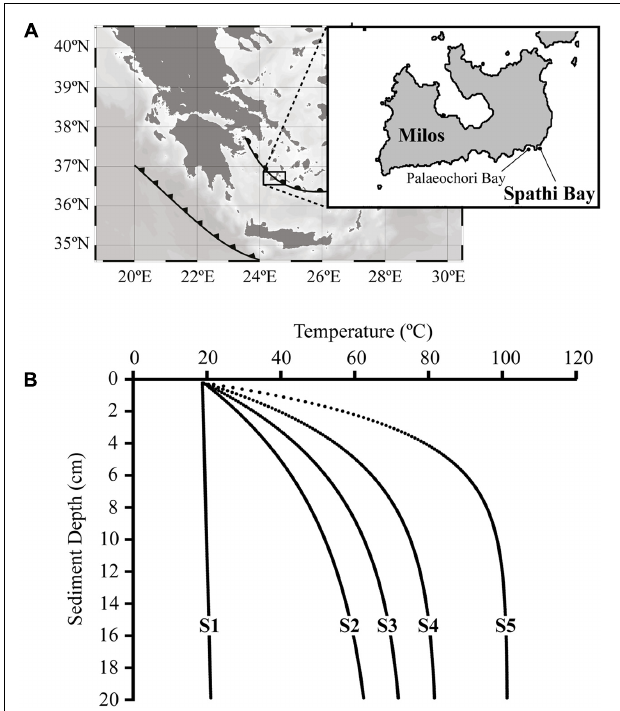
FIGURE 1 | The thermal gradient studied in sediments of Spathi Bay, Milos Island, Greece. (A) As part of the Hellenic back-arc and fault (semi-circles and triangles, respectively), Milos Island is one of the largest hydrothermal systems of the Mediterranean Sea [modified after Giovannelli et al. (2013)]. The study site Spathi Bay is located 500 m away from Palaeochori Bay, where most geochemical and microbiological investigations from Milos Island have been performed (see Main Text). (B) Modeled temperature profiles in sediments of Spathi Bay calculated for every 100 µ m from surface until 20 cm of sediment depth (see Materials and Methods section). Prior to sampling, stations S1 to S5 were selected based on temperatures recorded in situ at 5 cm sediment depth. Station S1 represents the reference sediments with temperatures below 20 ◦ C, while hydrothermally influenced stations S2 to S5 are characterized by a steep increase in temperature with